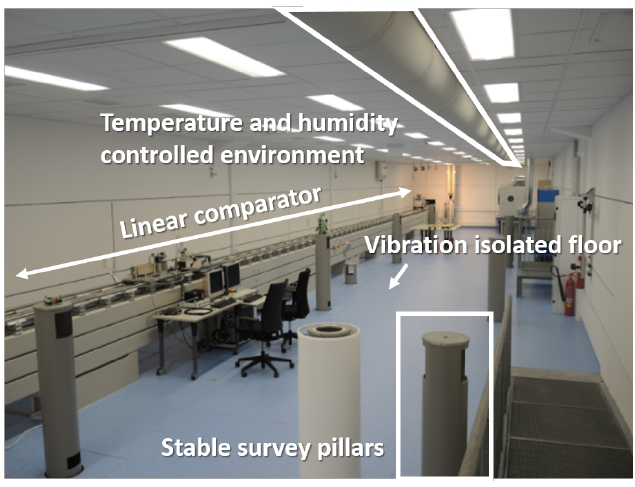
Figure 2. IGMS measurement